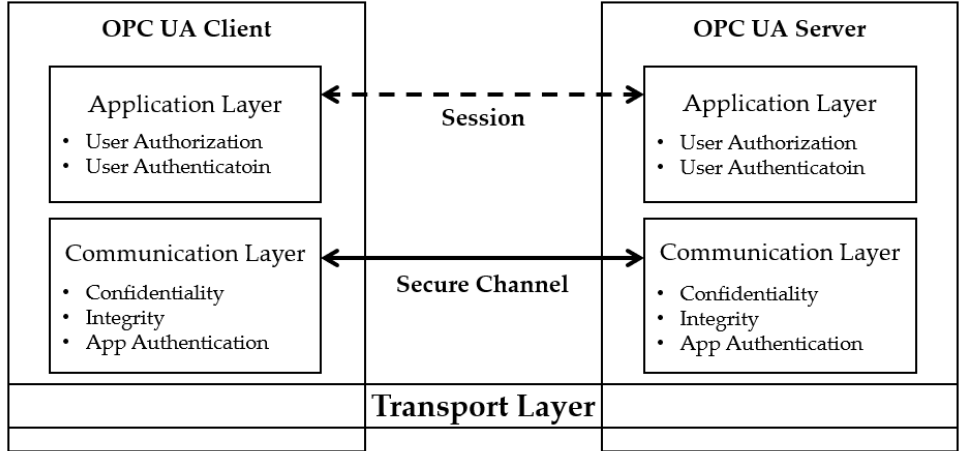
Figure 4. OPC UA security architecture.